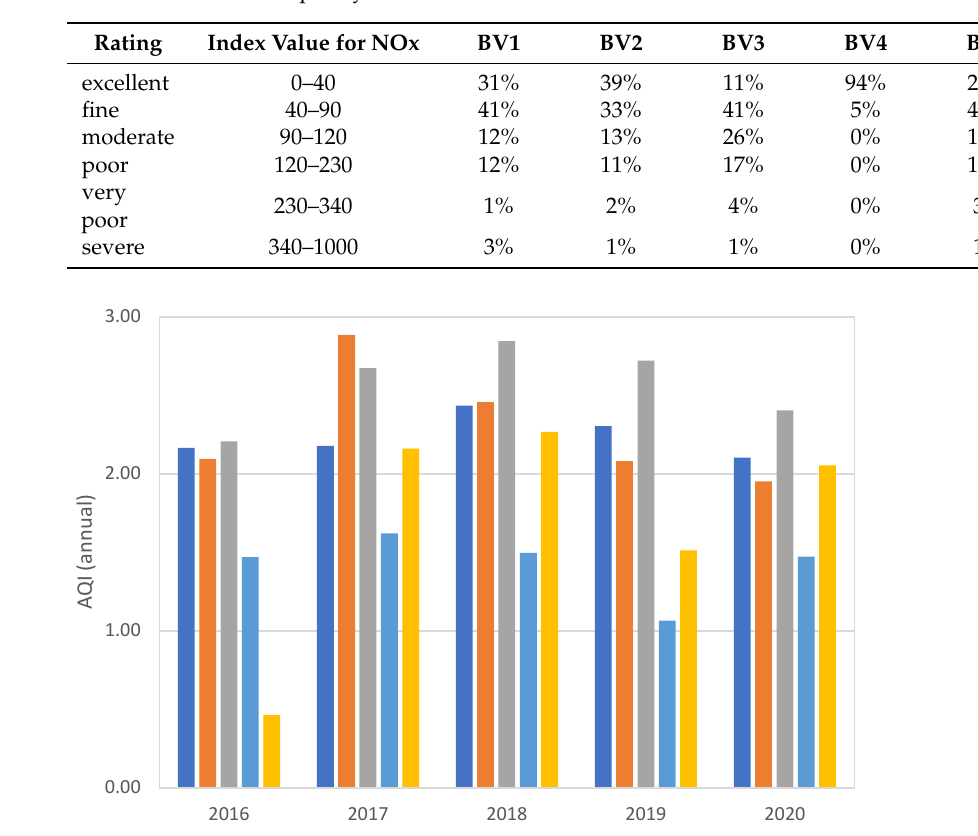
Table 6. NOx index frequency of occurrence.